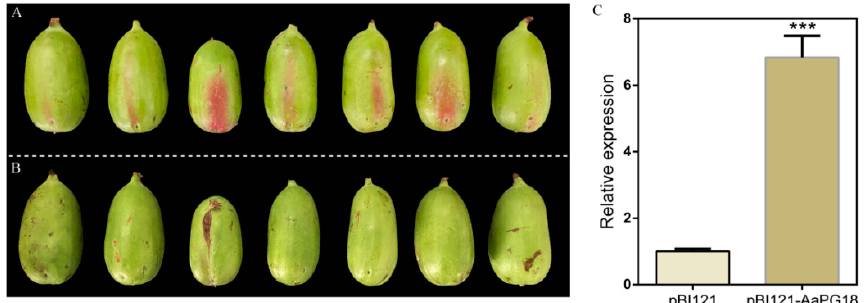
Figure 6. Homologous overexpression in fruits of A. arguta “RB-4”. ( A ) Phenotype of the side infiltrated with pBI121–AaPG18 presenting an obvious red color. ( B ) Phenotype of the side infiltrated with pBI121 presenting no change. ( C ) Expression level of AaPG18 in “RB-4” fruits infiltrated with pBI121–AaPG18 and pBI121. Similar to strawberry fruit, the left and right sides of one fruit were injected with pBI121–AaPG18 and pBI121, respectively. Values are presented as means ± SD for three replicates. Statistical significance: *** p <